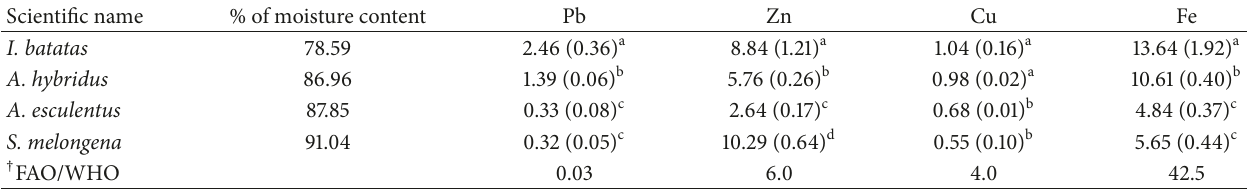
Table 3: Percentage of moisture content and mean ( ± standard deviation) of heavy metal levels (mg/100g) in the four vegetables ( 𝑛 =